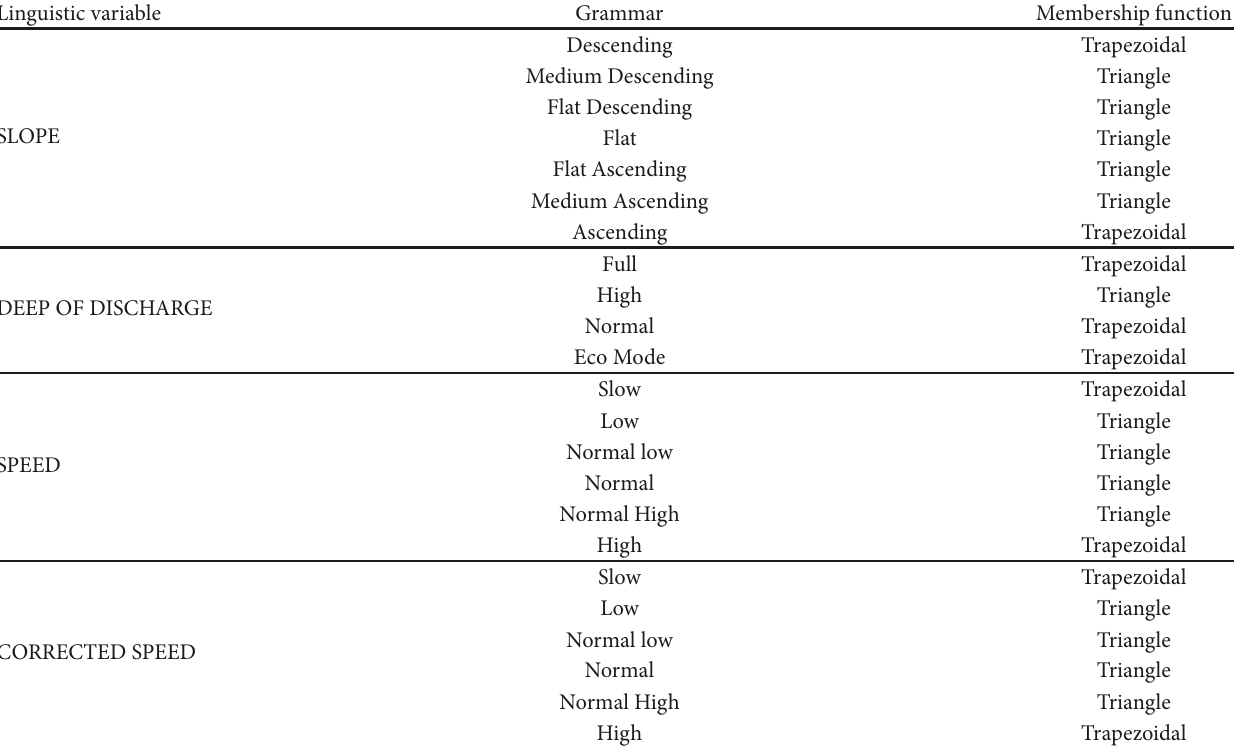
Table 4: Description of the fuzzy